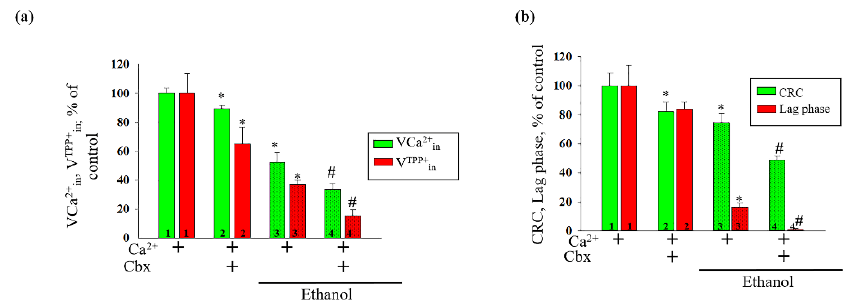
Figure 2. Quantitative characteristics of the effect of Cbx on the Ca 2+ -induced mPTP opening in the Control and Ethanol RLM; ( a ) quantitative analysis of V Ca2+ in and V TPP+ in ; ( b ) quantitative analysis of the CRC (calcium retention capacity) and of the lag phase. The values shown are the means ±SD from three independent experiments; * p ≤ 0.05 compared with the control value in the RLM without additions (columns 1); # p ≤ 0.05 compared with the control value in the Ethanol RLM without additions (dotted columns 3).